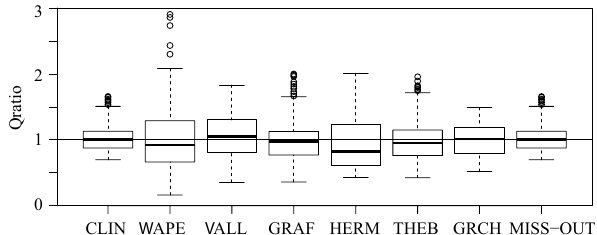
Fig. 2. Box plot of Qratio values by